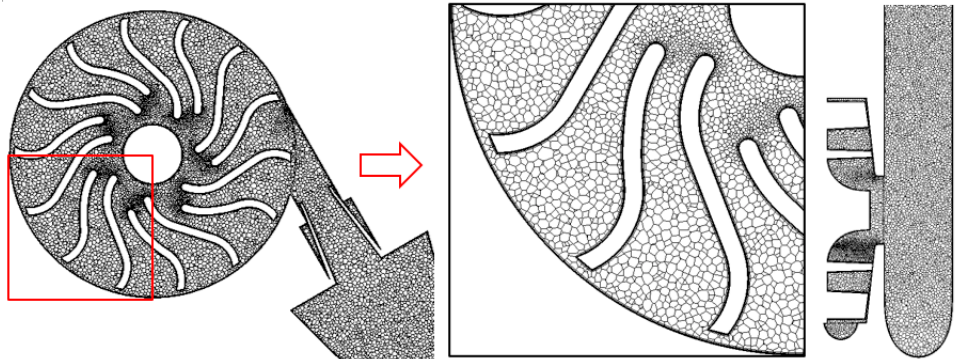
Figure 2. Computational grids of the impulse water turbine. Five grid sizes are considered at the design condition to investigate the grid sensitiv- ity [39,40]. The calculated efficiency and the head with the same numerical settings are shown in Table 3. The results reveal that the efficiency and the head became constant after the grid number was more than 1.25 × 10 6 . Therefore, the grid number of 1.25 × 10 6 was